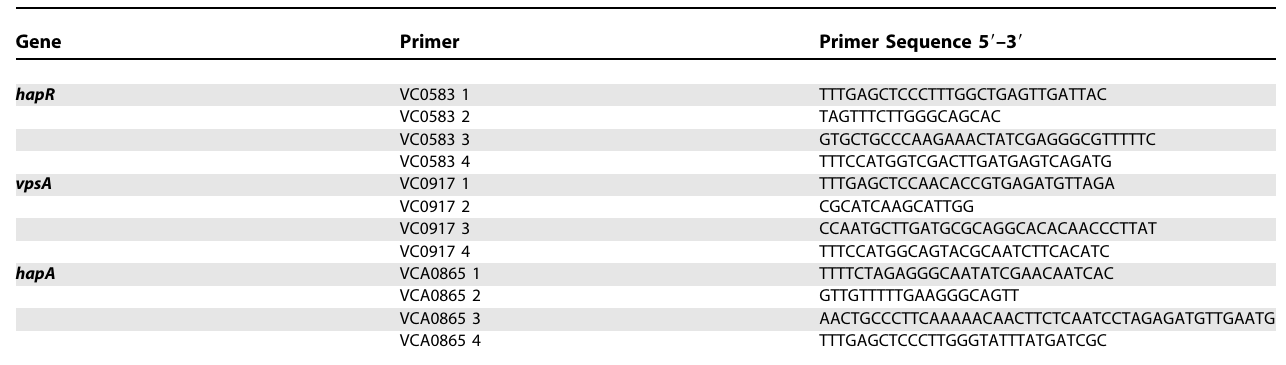
Table 1. Primers Used for Genetic Manipulations